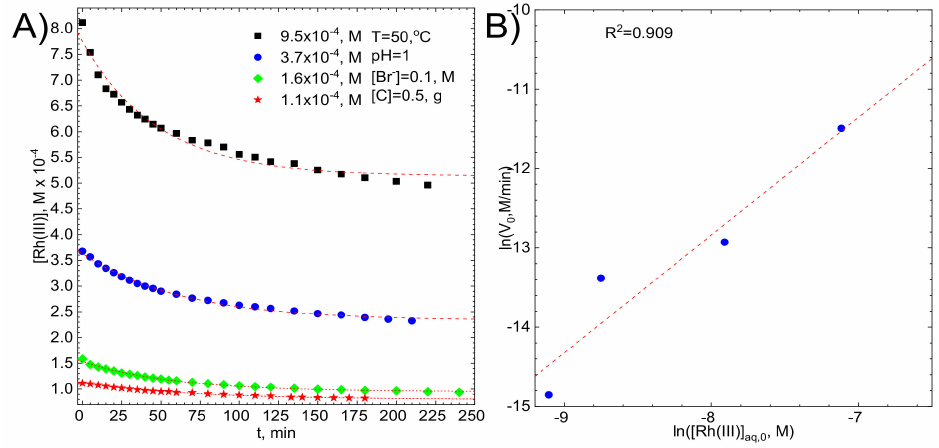
Figure 7. ( A ) kinetic curves for various initial concentrations of Rh(III) with fitted exponential curves, ( B ) graphical determination of the reaction order. Experimental conditions: T = 50 ◦ C, [C] = 0.5g, pH = 1, [Br] − = 0.1 M, V = 1200